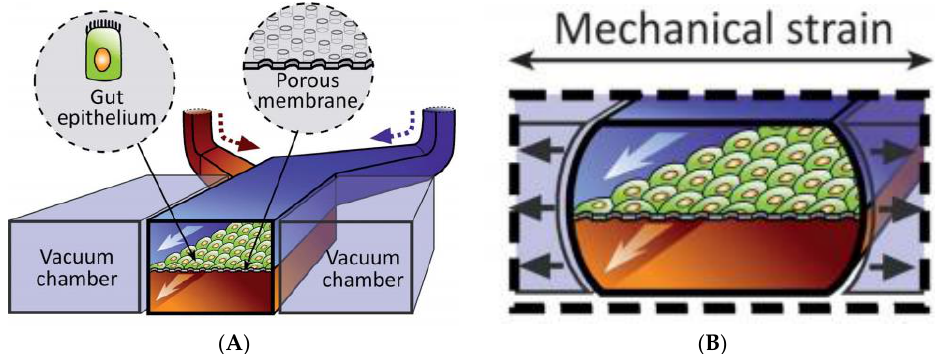
Figure 5. Organ-on-a-chip. ( A ): The central microchannel comprises a flexible porous extracellular matrix (ECM)-coated membrane lined with gut epithelial cells, positioned between two vacuum chambers. ( B ): Mechanical strain is applied to the gut intestinal monolayers by suction from the vacuum chambers. Adopted with permission from [202], Royal Society of Chemistry, 2001.